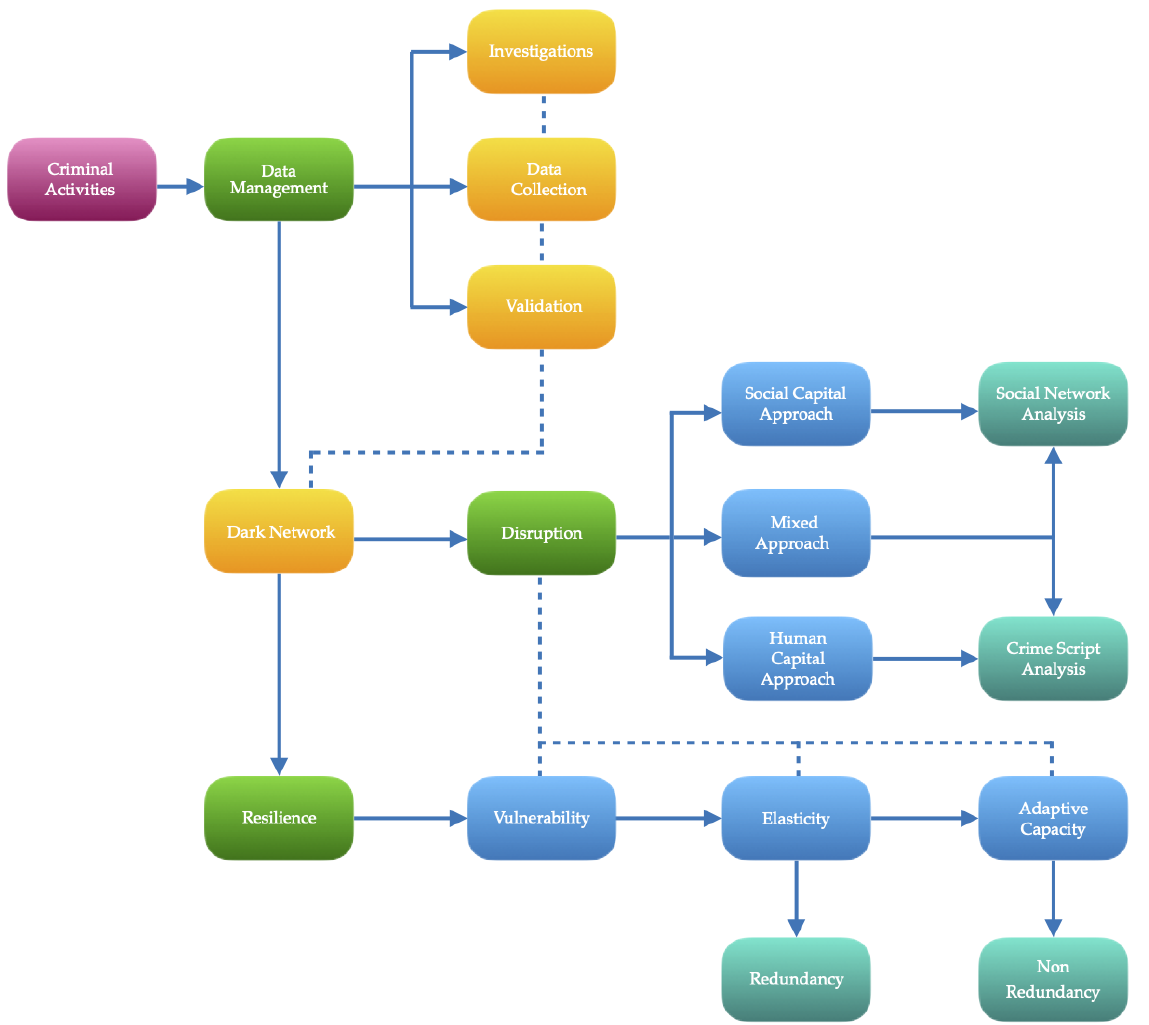
Figure 1. Conceptual map of the collected material for the